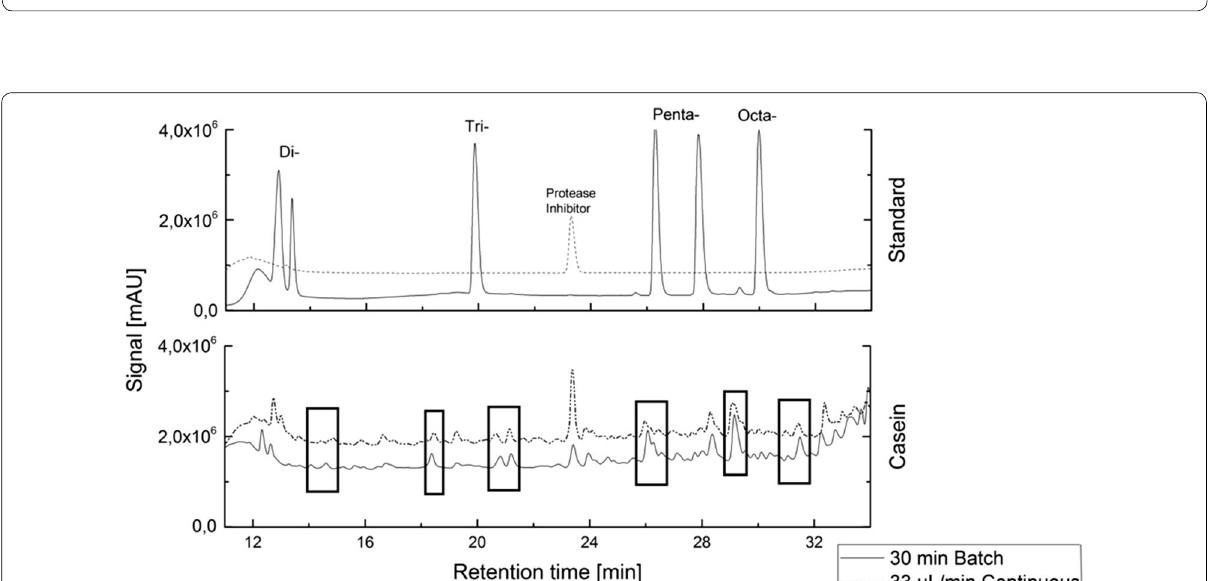
Fig. 6 Comparison of batch and continuous hydrolysis. Protein hydrolysates of native and immobilized enzymes show a similar peptide